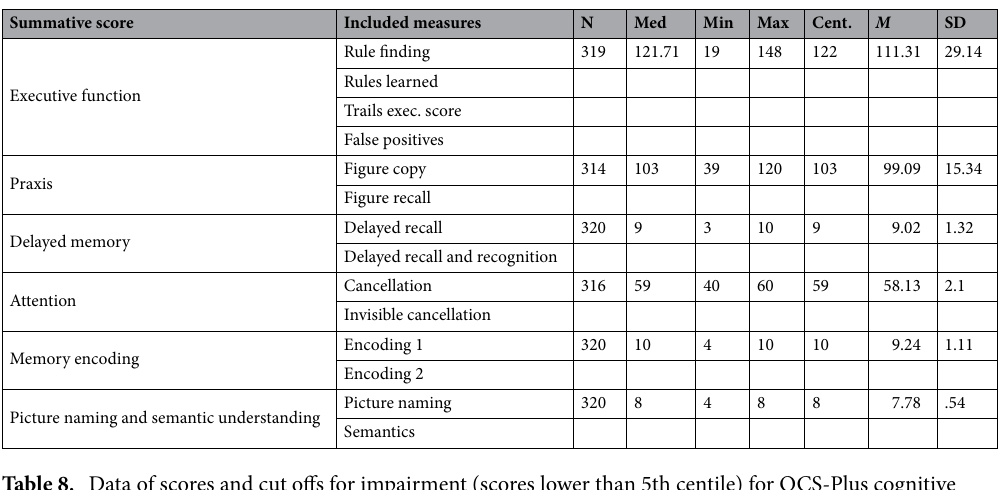
Table 8. Data of scores and cut offs for impairment (scores lower than 5th centile) for OCS-Plus cognitive domains. Oxford Cognitive Screen-Plus (OCS-Plus). Domains were theoretically grouped by OCS-Plus sub- task design into cognitive domains, which were used to generate domain scores for per participant. Code and exact calculations are found in our data scripts (https:// osf. io/ cfmwk/? view_ only= 7e5cd f8d96 3b465